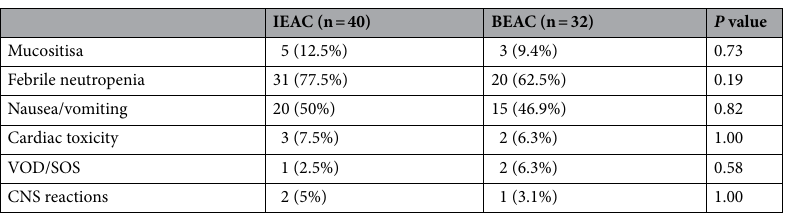
Table 3. Toxicities between IEAC and BEAC groups. VOD/SOS Hepatic Veno-occlusive disease (VOD) or Sinusoidal Obstruction Syndrome (SOS), CNS central nervous system. Mucositisa and Nausea/vomiting: grade